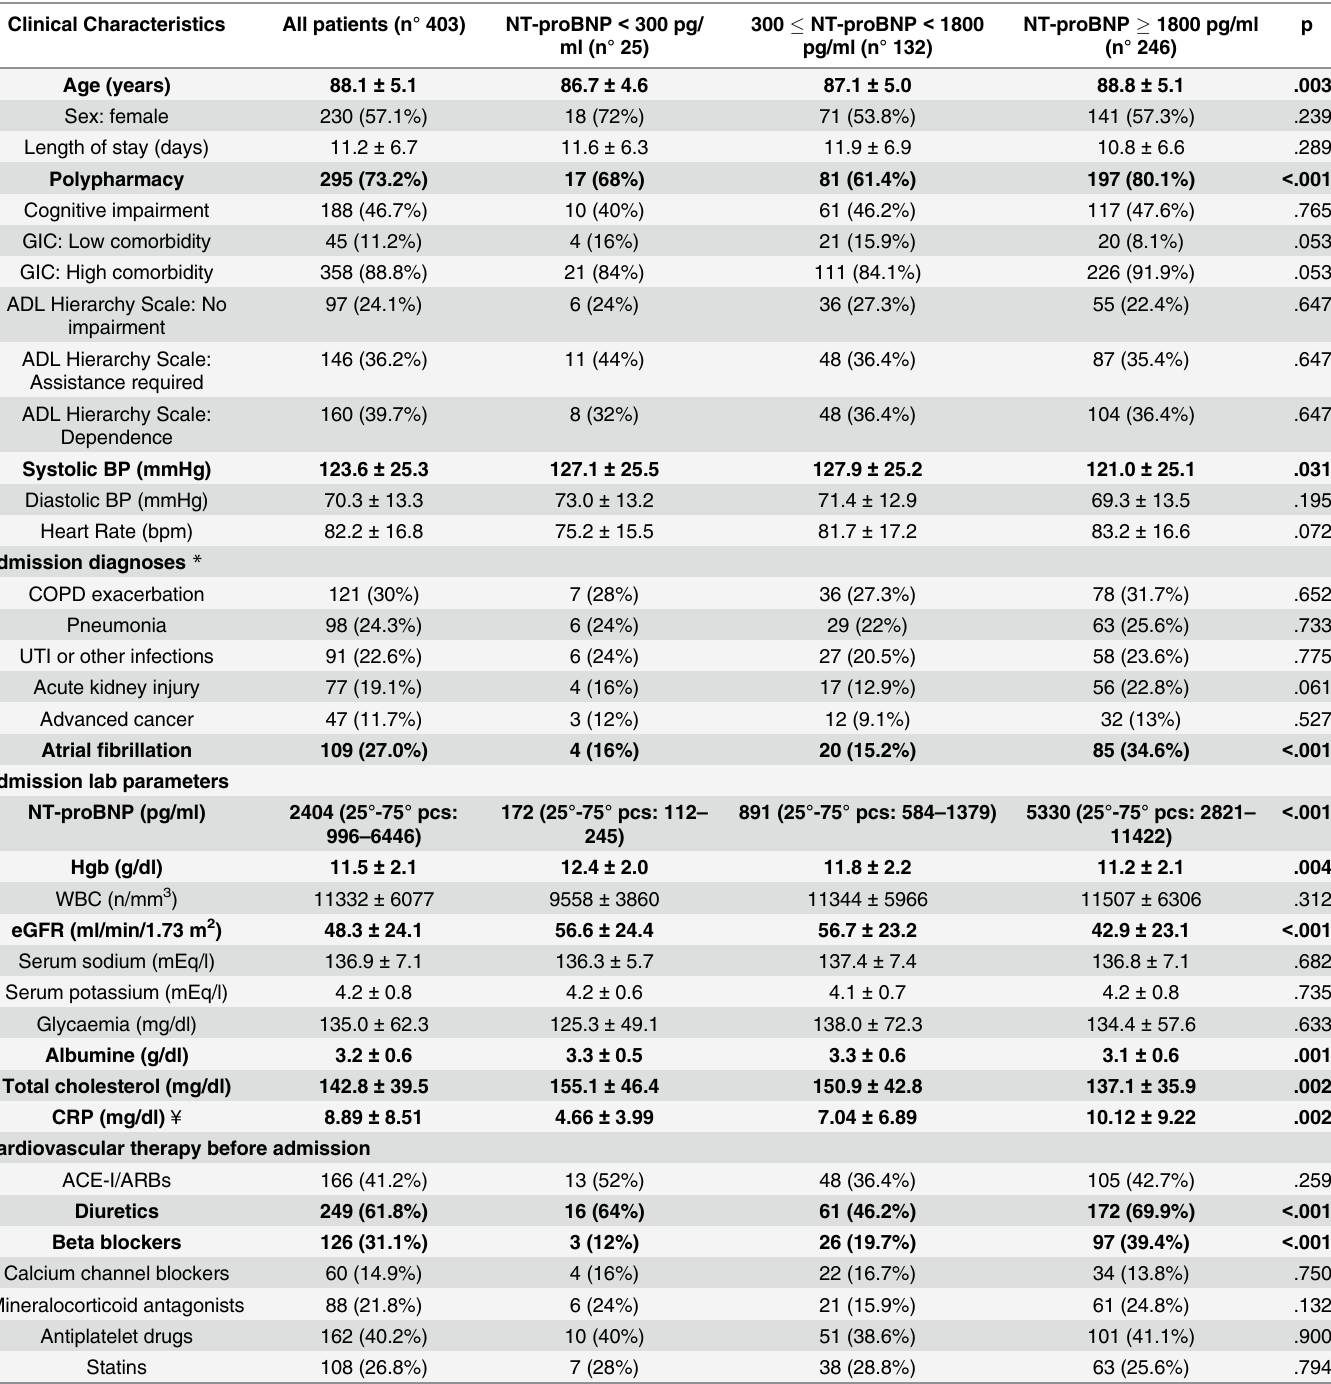
Table 1. General